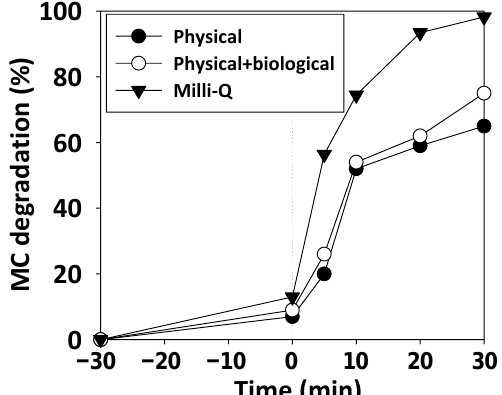
Figure 8. MC photodegradation (20 mg/L) at catalyst concentration of 800 mg/L under UV radiation. Matrix composed of real wastewater that received a physical treatment (black circles), matrix that received a physical and biological treatment (white circles), and milli-Q water (black triangles).